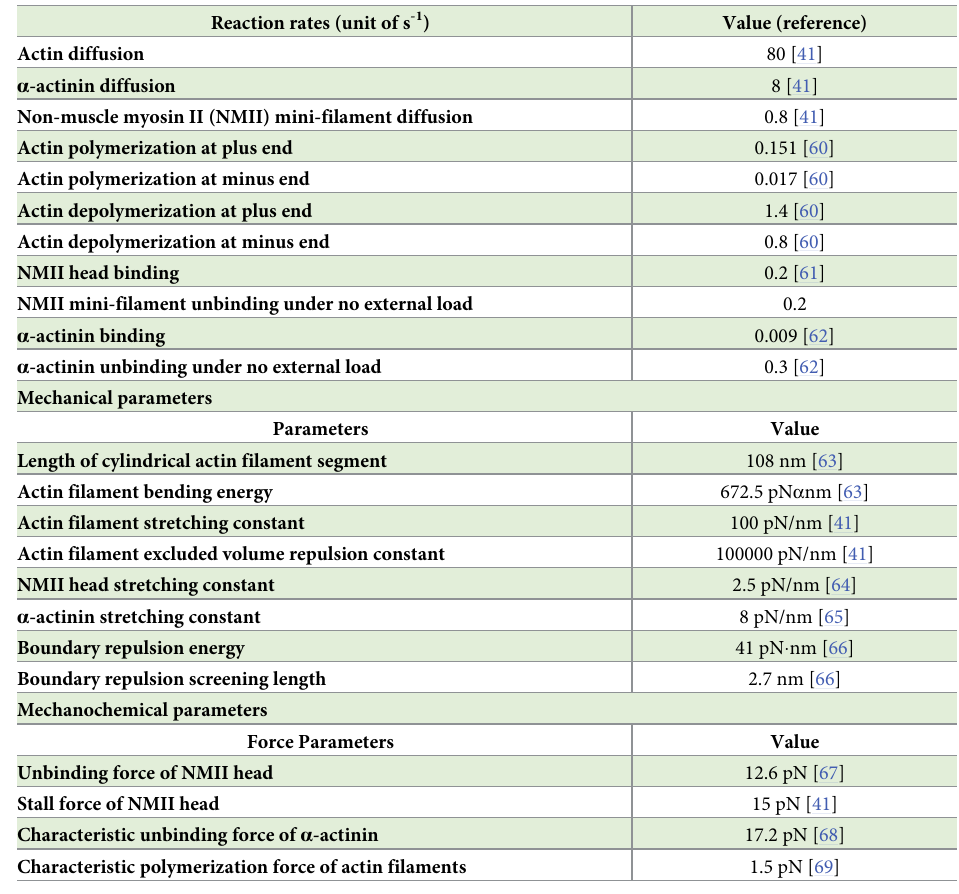
Table 1. Parameters for the